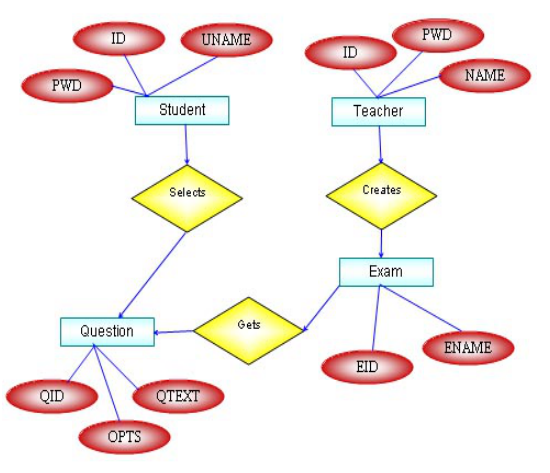
Figure 3. This is Flow chart of research